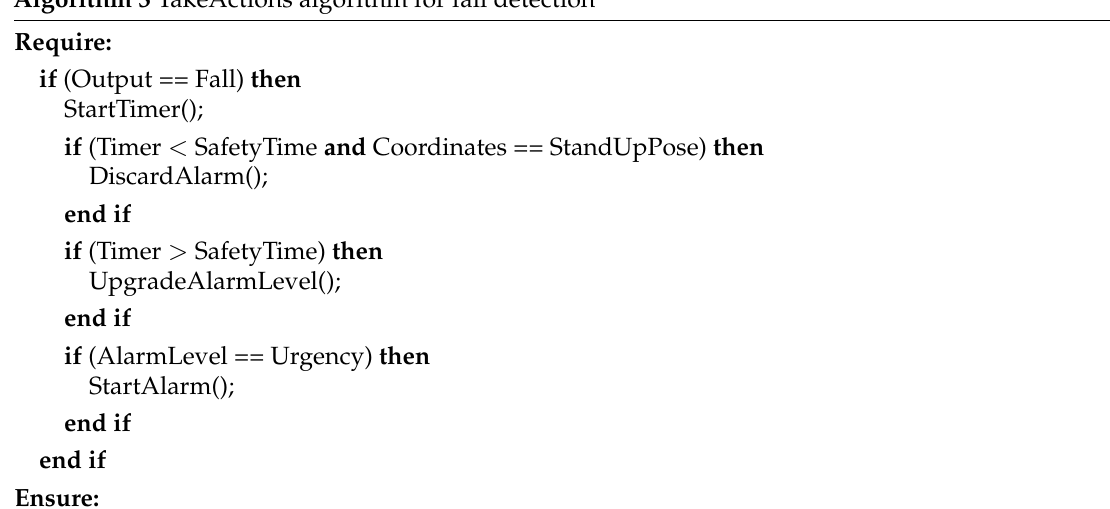
Algorithm 3 TakeActions algorithm for fall